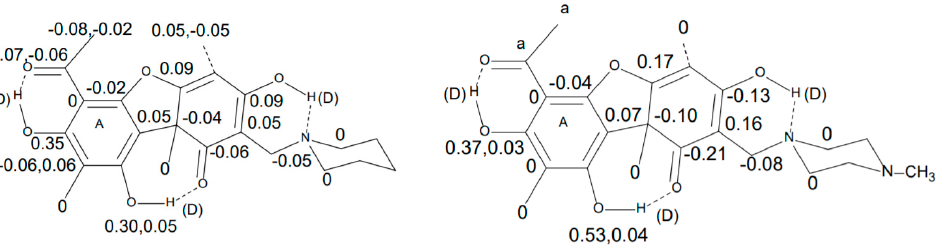
Figure 20. Zwitter ionic form of piroxicam.